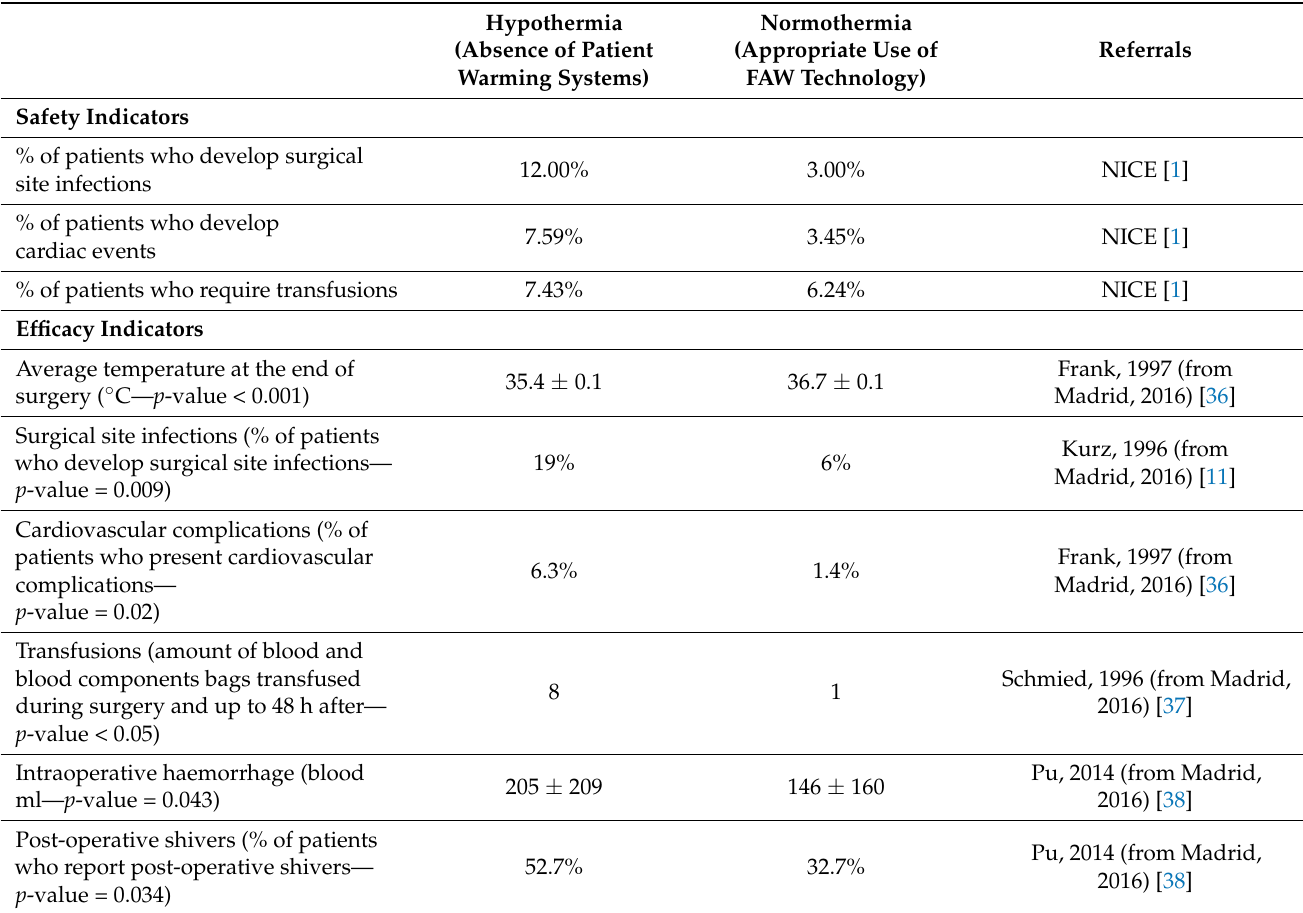
Table 3. Safety and efficacy